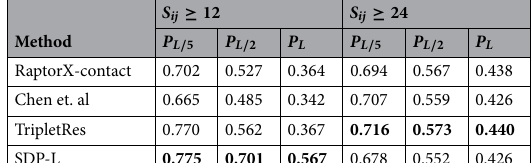
S ij ≥ 12 S ij ≥ 24 P L / 5 P L / 2 P Method